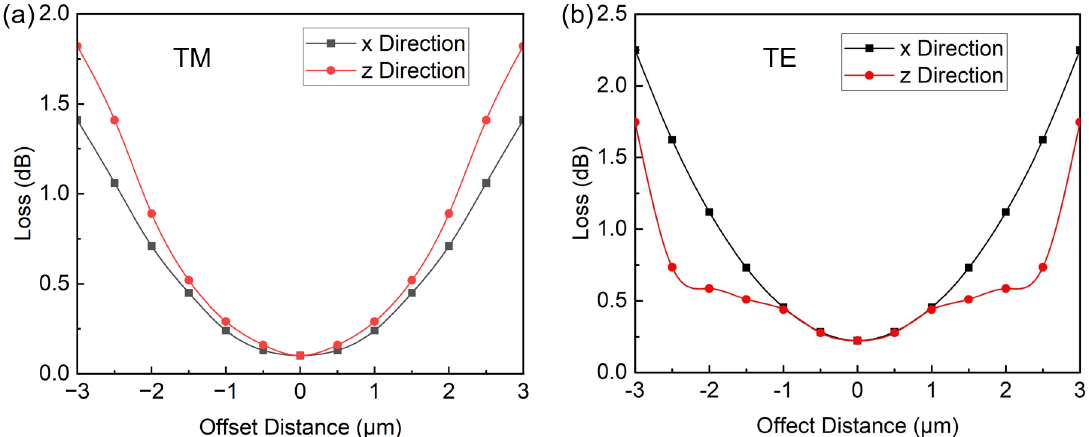
Figure 4. ( a ) Alignment offset tolerance analysis in x and z directions for TM mode. ( b ) Alignment offset tolerance analysis in x and z directions for TE mode.